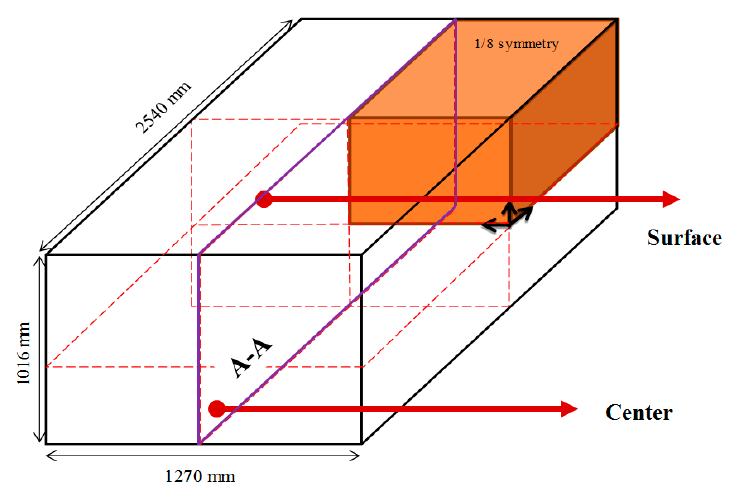
Figure 3. Geometry of the large-sized ingot and the symmetrical sets used in the FE simulation of the quenching process. Distributions of the transformed phases are displayed in the section A-A.